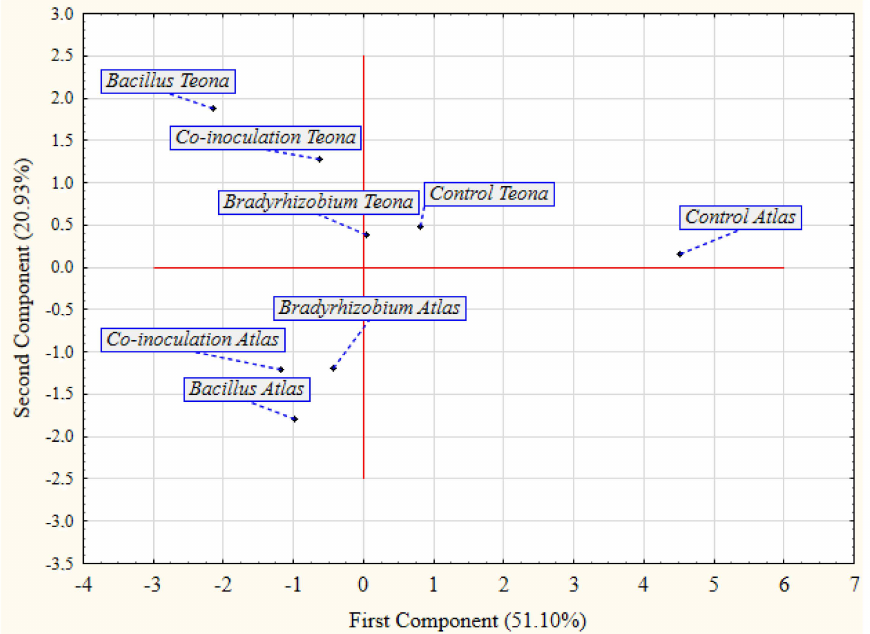
Figure 1. Principal component analysis (PCA) for the effect of seed bio-priming treatments on the examined parameters of soybean cultivars in germination test.